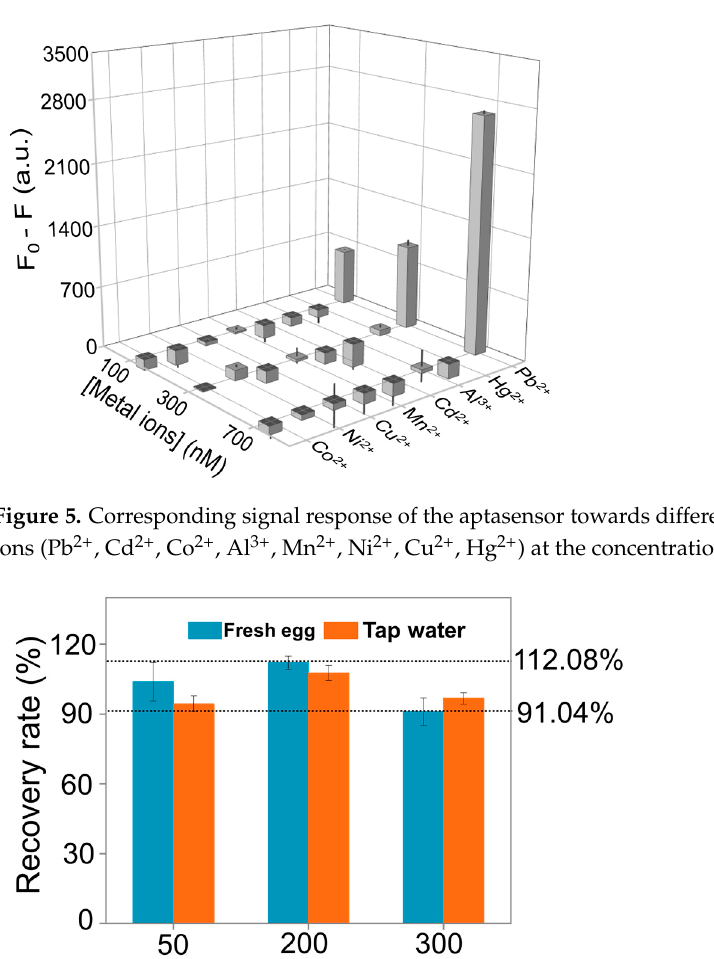
Figure 5. Corresponding signal response of the aptasensor towards different concentrations of metal ions (Pb 2+ , Cd 2+ , Co 2+ , Al 3+ , Mn 2+ , Ni 2+ , Cu 2+ , Hg 2+ ) at the concentration of 100, 300 and 700 nM.